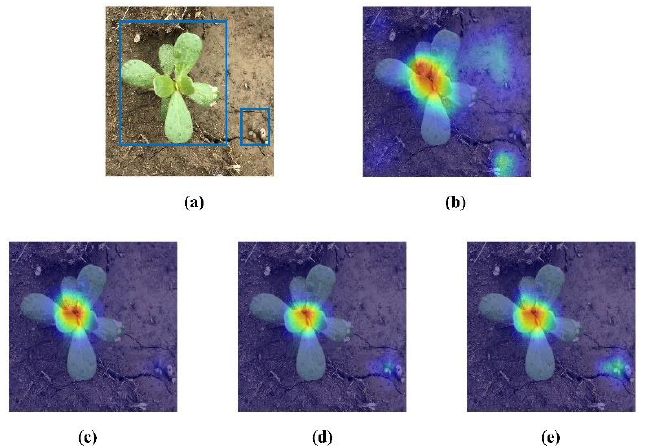
Figure 5. Visual heat map of attentional mechanisms, where ( a ) represents the original image; ( b ) represents the results of using the base model; ( c ) represents the results of using the base model and the SE attention mechanism; ( d ) represents the results of using the base model and the CBAM attention mechanism; ( e ) represents the results of using the base model and the ECA attention mechanism.